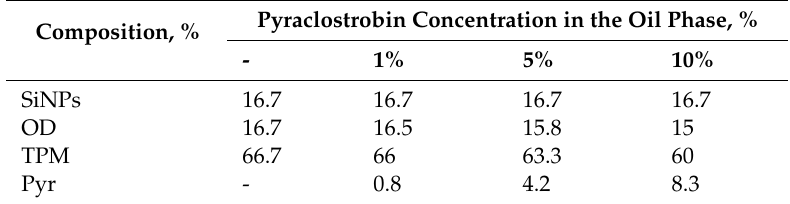
Table 2. The composition of PyrSMCs depending on Pyr concentration in the oil phase, %. Pyraclostrobin Concentration in the Oil Phase, % Composition, %